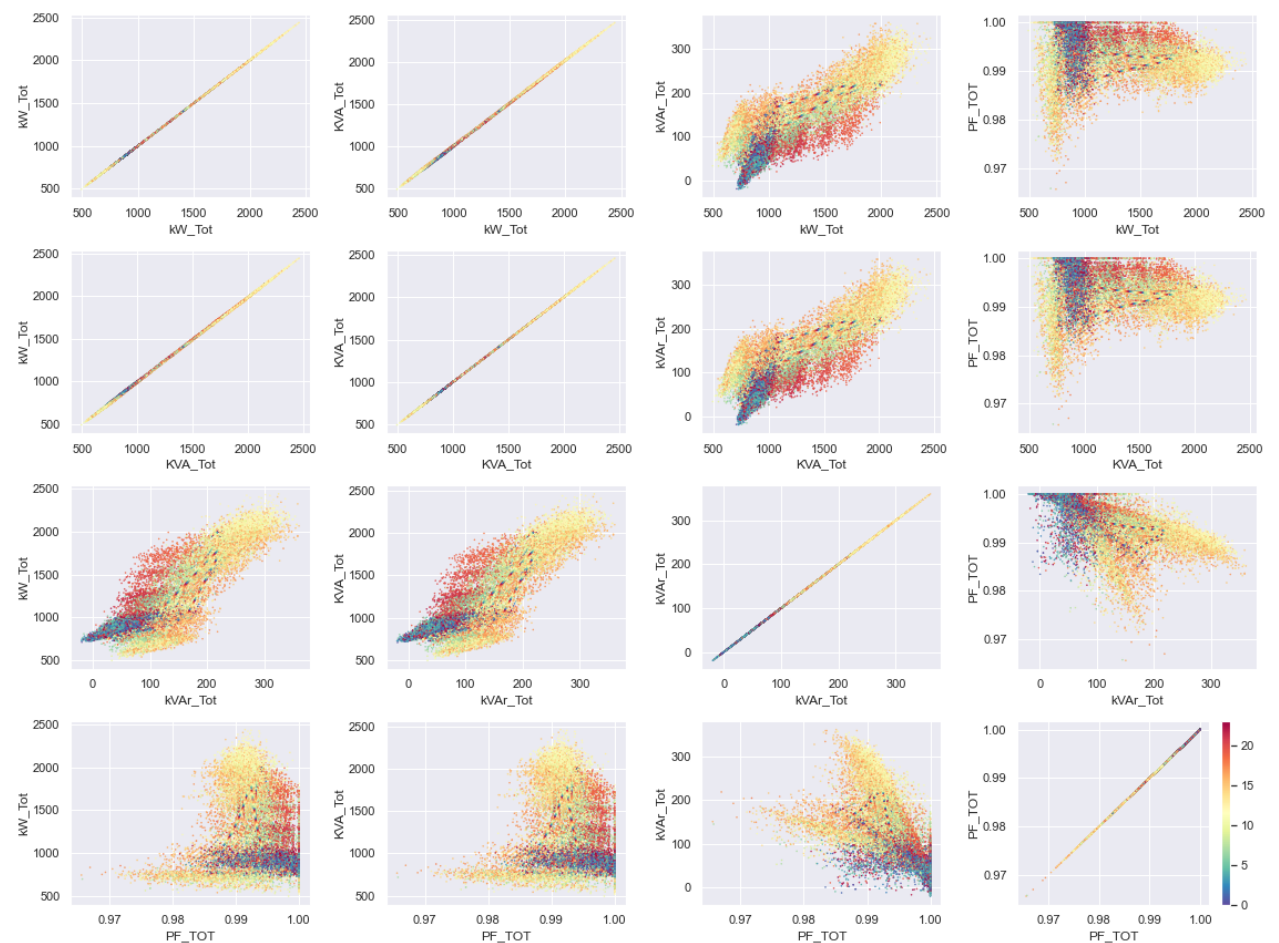
Figure 17. Correlograms of the extended variables in Scenario A. Each color represents the hour of the day.